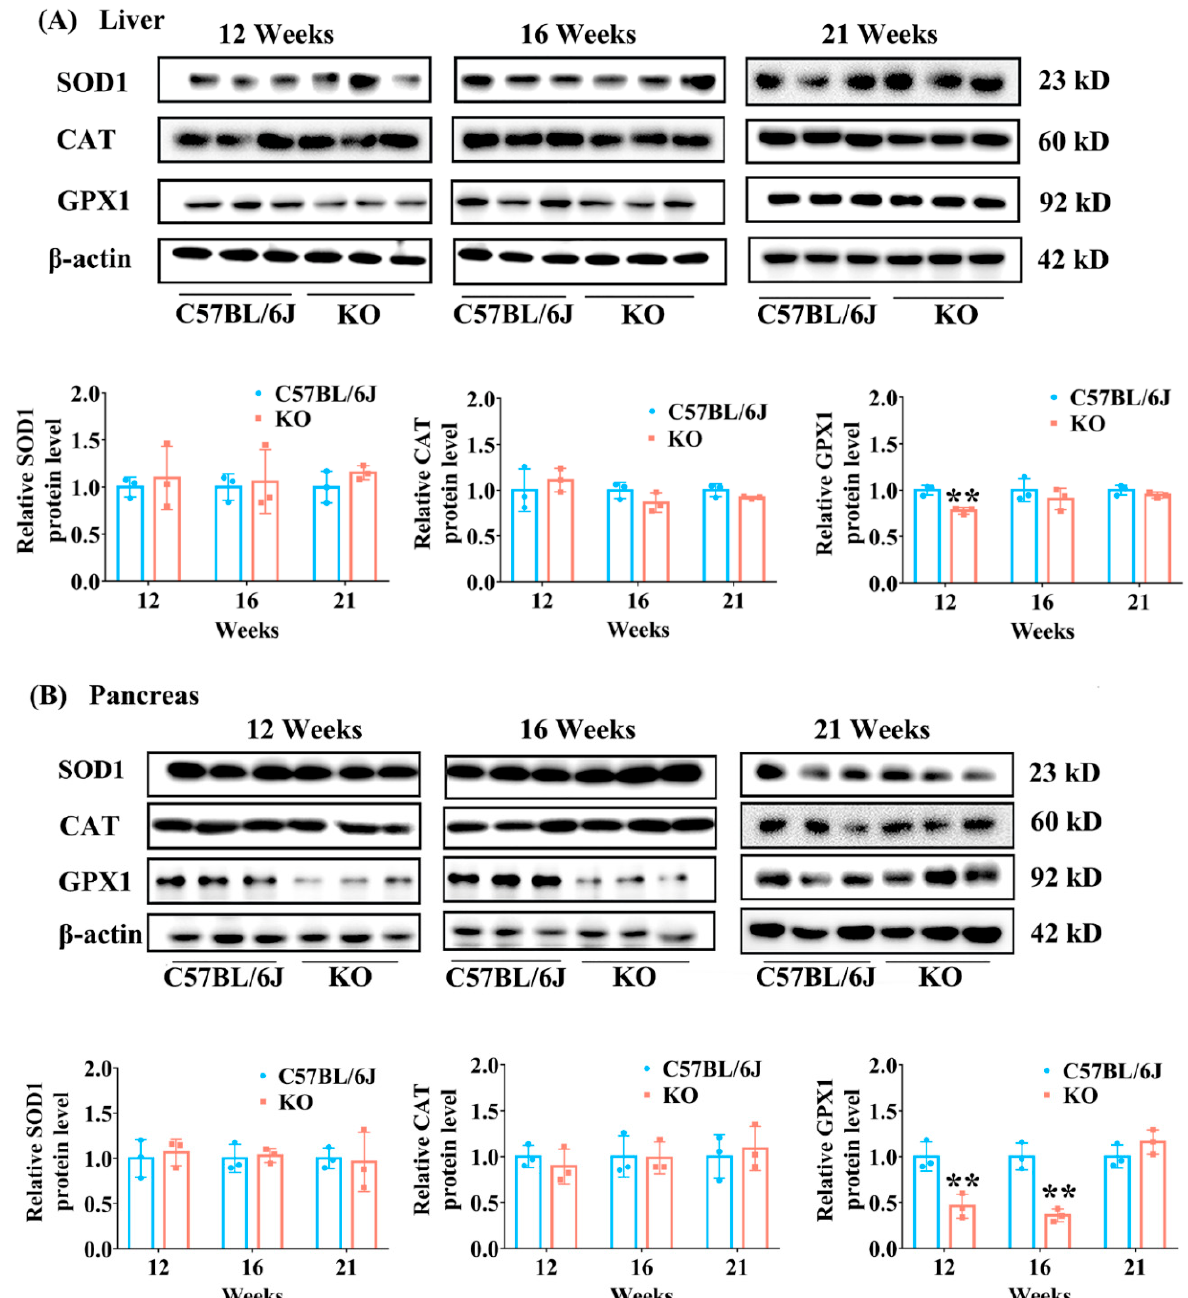
Figure 7. The expression levels of SOD1, CAT and GPX1 in the liver and pancreas of KO and C57BL/6J mice of different ages. ( A ) Representative Western blot bands of SOD1, CAT and GPX1 (upper panel) and their semi-quantification analysis normalized to β -actin (lower panel) in liver tissues. ( B ) Representative Western blot bands of SOD1, CAT and GPX1 (upper panel) and their semi-quantification analysis normalized to β -actin (lower panel) in pancreas tissues. SOD1: Cu/Zn SOD; GPX1: cellular glutathione peroxidase. Data were expressed as mean ± SD ( n = 3). ** p < 0.01, compared with C57BL/6J mice.